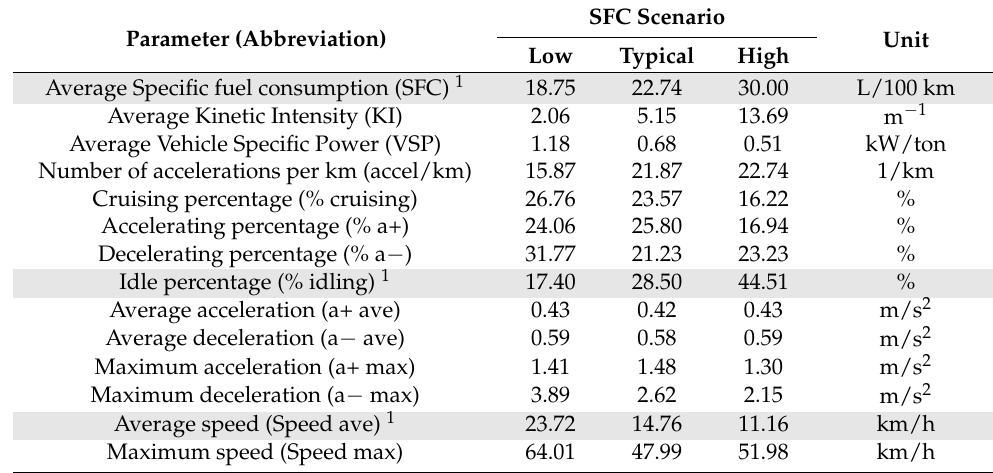
Table 5. Characteristic parameters that describe the aggressive, typical, and eco-friendly driving patterns exhibited by drivers serving the CircuitoTec route.